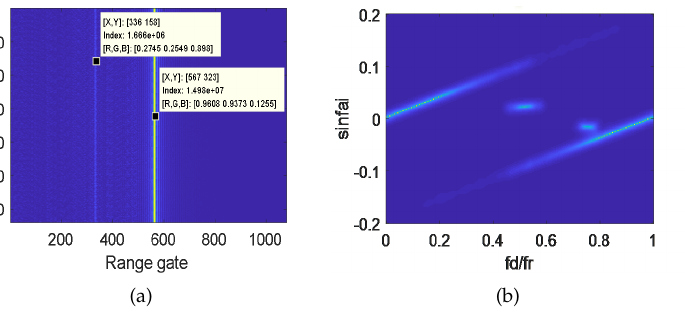
Figure 10. Simulated echo after adding a strong jamming target: ( a ) echo after adding a strong jamming target, ( b ) the Capon after adding a strong jamming